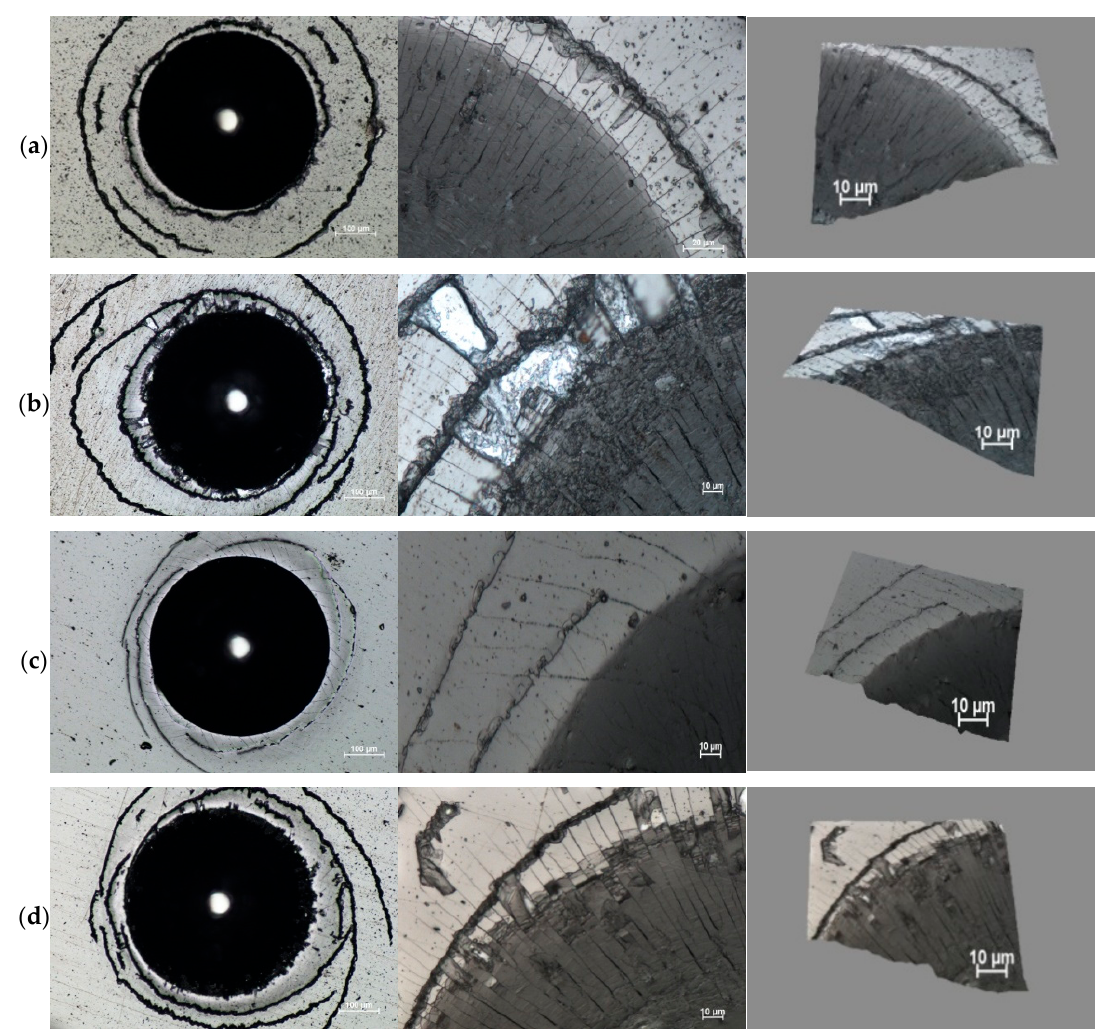
Figure 12. Results of Rockwell C test: ( a ) square root carbon content variation profile in the range of 0–50 at.%, ( b ) square root carbon content profile in the range of 50 to 85 at.%, ( c ) parabolic carbon content profile in the range of 0–50 at.%, ( d ) parabolic carbon content profile in the range of 50 to 85 at.%.